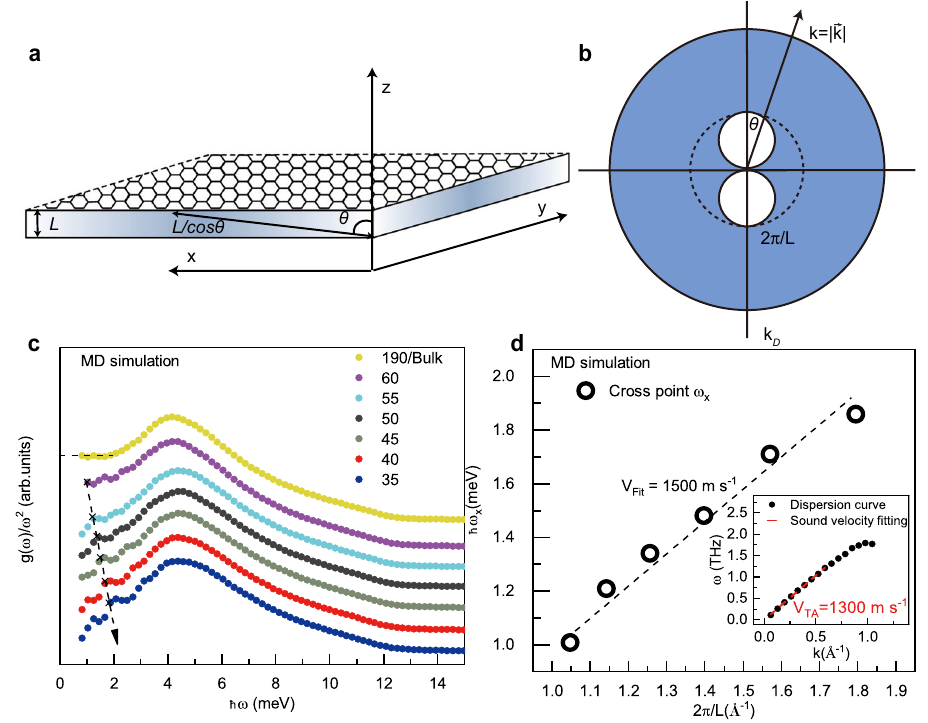
Fig. 5 Theoretical model and validation from MD simulations. a The con fi ned geometry considered. The system size in the ( x , y ) directions is much larger than that in the z direction, L z ≪ L x , L y . The system is assumed to be rotational invariant in the 2-dimensional ( x , y ) subspace. The angle θ is de fi ned with respect to the vertical z axes. b The wavevector phase space corresponding to the con fi ned geometry of panel ( a ). c The normalized VDOS of slab amorphous ice with different con fi nement sizes L (from the bulk sample in yellow color to the strongly con fi ned sample in dark blue color). The black cross symbols show the crossover frequency ω × de fi ned in the main text. d The crossover scale ω × as a function of the inverse con fi nement length 2 π / L . The dashed line is a linear fi t whose result is reported in Eq. (7). The inset shows the dispersion curve of the transverse acoustic modes in amorphous ice and the fi tting curve giving v TA ≈ 1300 m s − 1